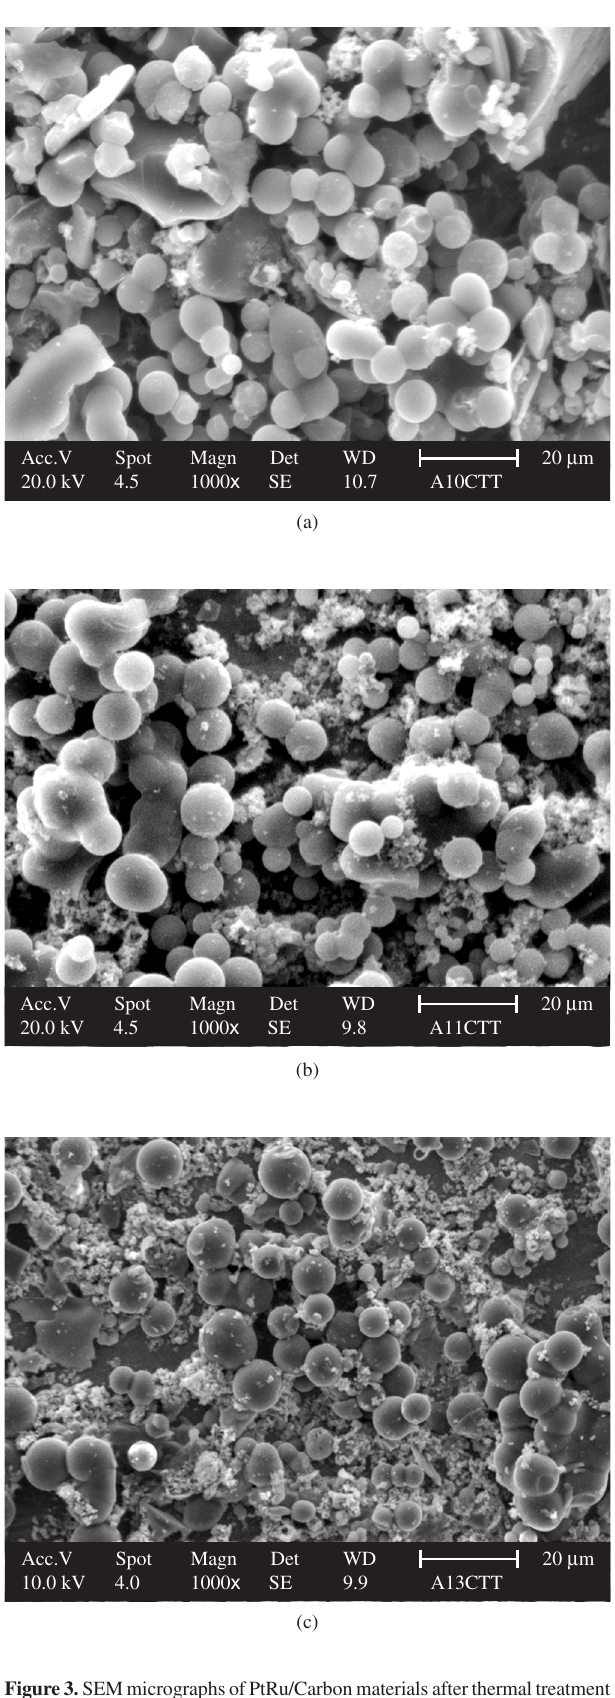
Figure 4. Cyclic voltammograms of PtRu/Carbon materials in 0.5 mol.L -1